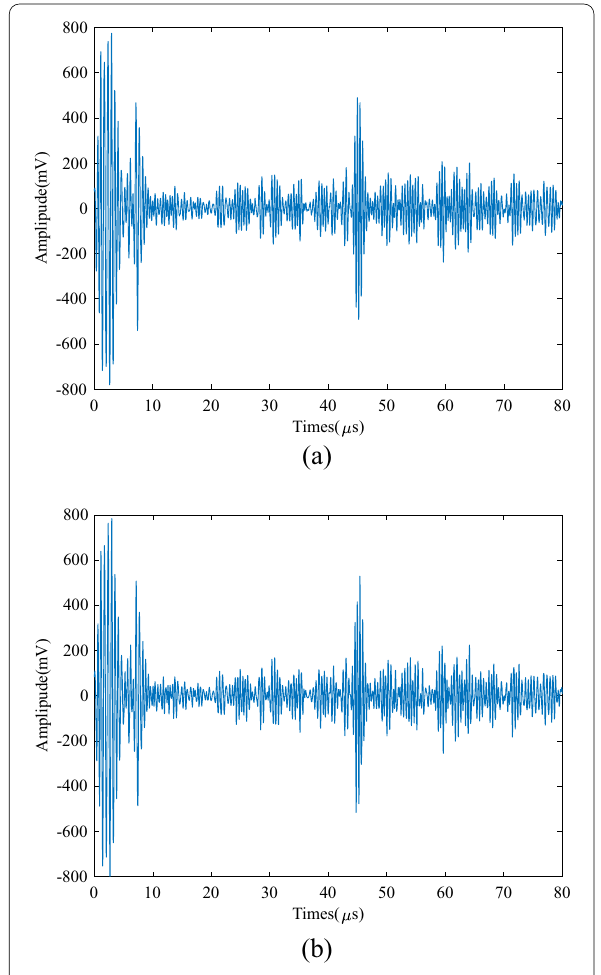
Figure 9 ( a ) Reconstruction signal of VMD decomposition, ( b ) WT denoising